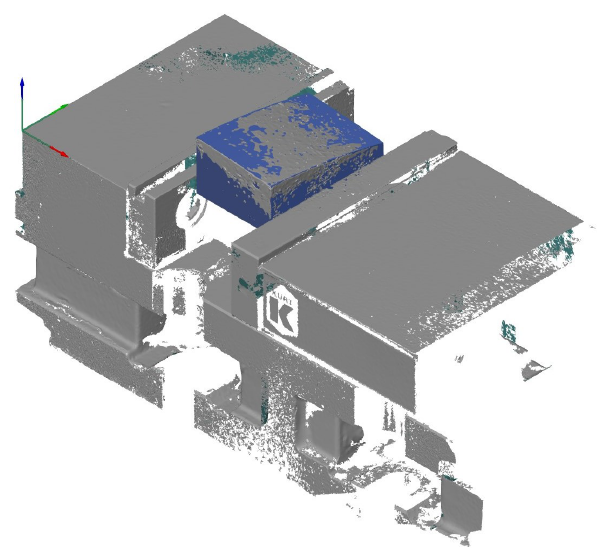
Figure 5. CAD aligned to scan of preform with WCS defined